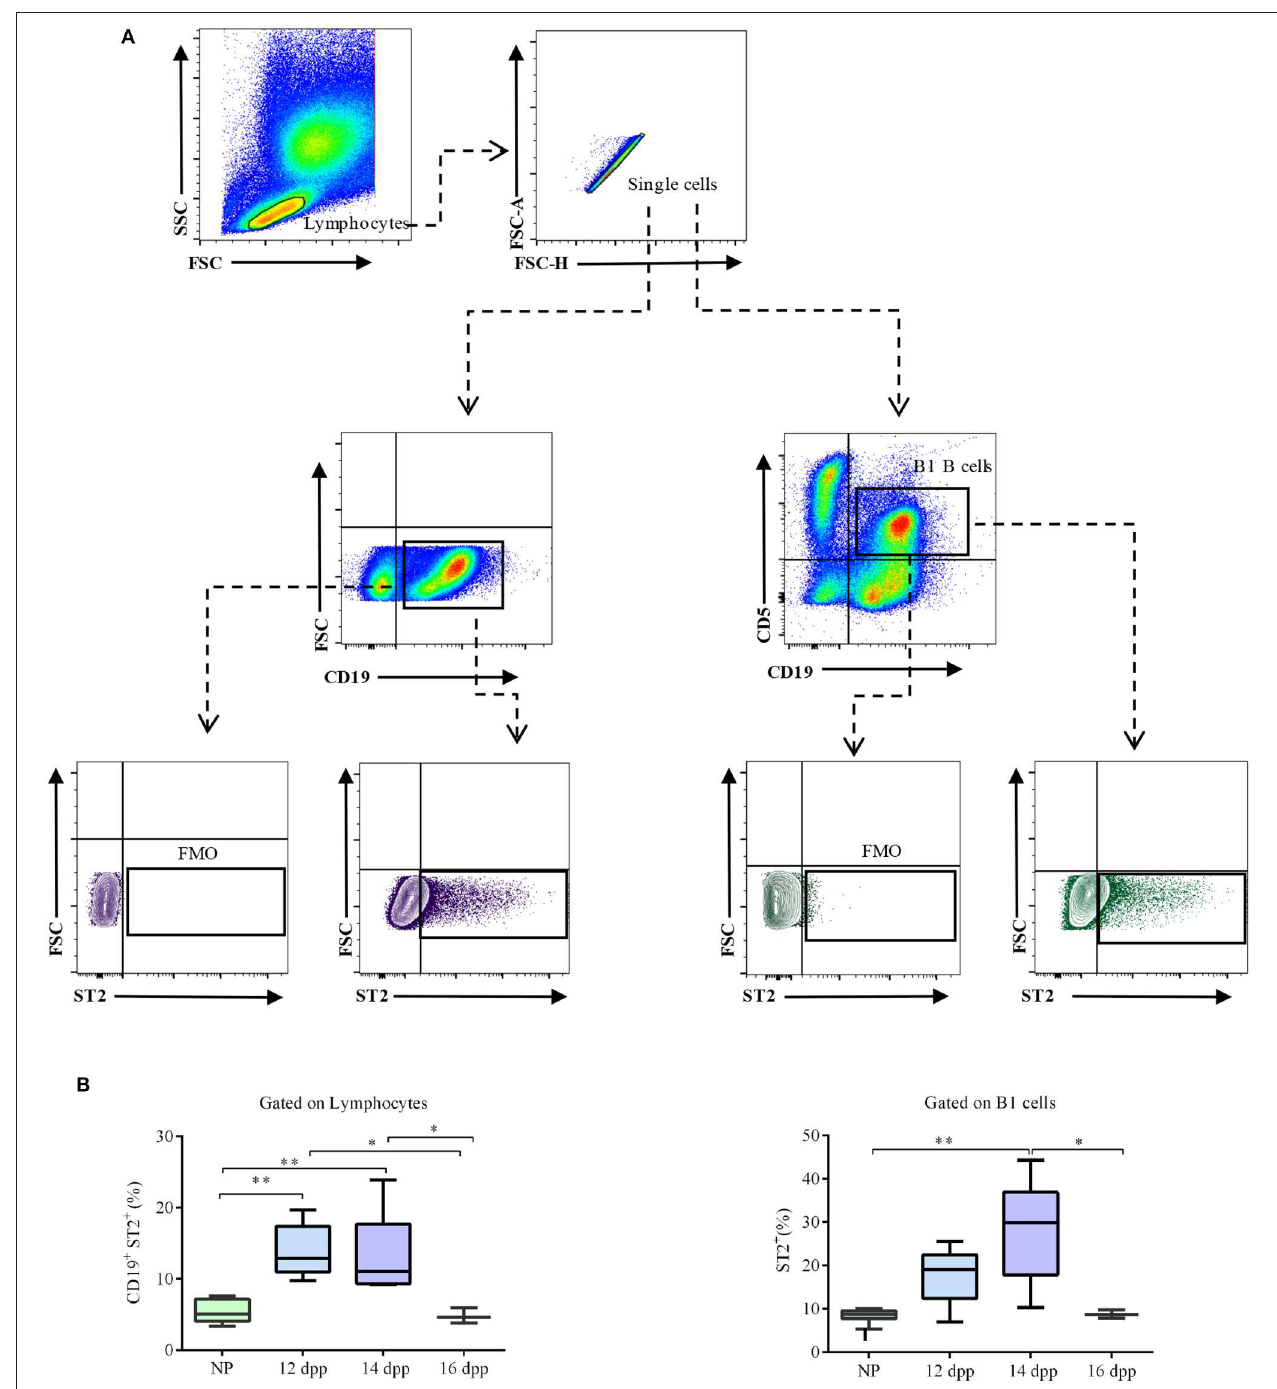
FIGURE 4 | Percentages of ST2-expressing total and B1 B cells in the peritoneal cavity of pregnant and non-pregnant mice. (A) Representative pseudocolor and contour plots showing gating strategy used to quantify percentages of ST2-expressing total CD19 + B cells as well as CD19 + CD5 + B1 B cells in the peritoneal cavity of pregnant and non-pregnant mice. Lymphocytes were gated by FSC vs. SCC, doublets were eliminated, and CD19 alone or in combination with and CD5 were used to define total as well as B1 B cells, respectively. Fluorescence minus one (FMO) was used as control. (B) Box and whisker plots showing percentages of ST2-expressing CD19 + B cells in peritoneal cavity of non-pregnant (NP; n = 9) and pregnant mice at day 12 (12 dpp; n = 5), 14 (14 dpp; n = 9), and 16 (16 dpp; n = 3) of pregnancy as well as percentages of ST2-expressing CD19 + CD5 + B1 B cells in non-pregnant (NP; n = 9) and in pregnant mice at day 12 (12 dpp; n = 5), 14 (14 dpp; n = 9), and 16 (16 dpp; n = 3) of pregnancy. Data are expressed as box and whisker plots showing median. * p < 0.05; ** p < 0.01 as analyzed by ANOVA followed by Tukey’s multiple comparisons test.